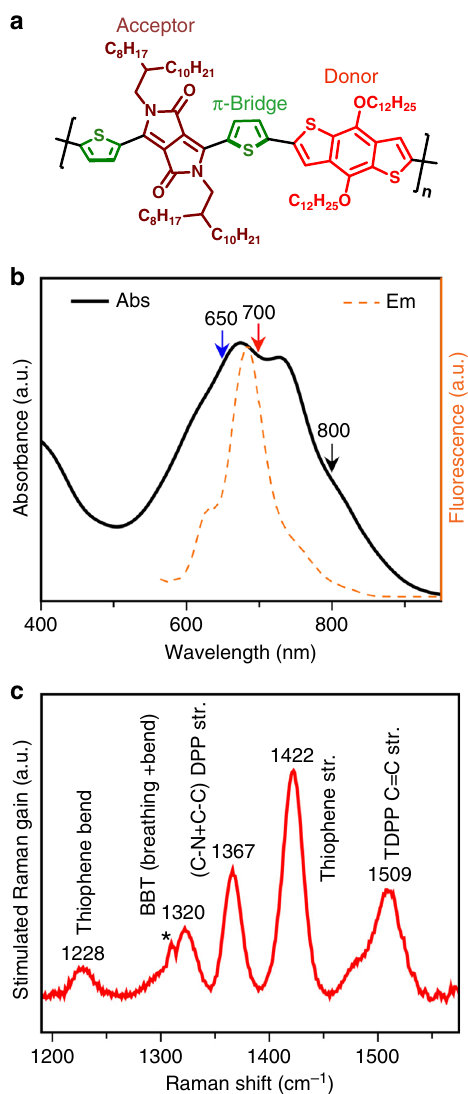
Fig. 2 Spectroscopic characterization of TDPP-BBT copolymer. a Structural representation of TDPP-BBT copolymer. b Steady-state absorption of the 90 μ M copolymer solution in chlorobenzene is represented by black curve while the emission spectra is represented by orange dotted curve where 570 nm is the excitation wavelength; 650, 700, and 800 nm are the pump wavelength used for transient absorption measurements. c Ground state stimulated Raman spectra of TDPP-BBT polymer in chlorobenzene where 816 nm is the excitation pulse. Asterisk mark